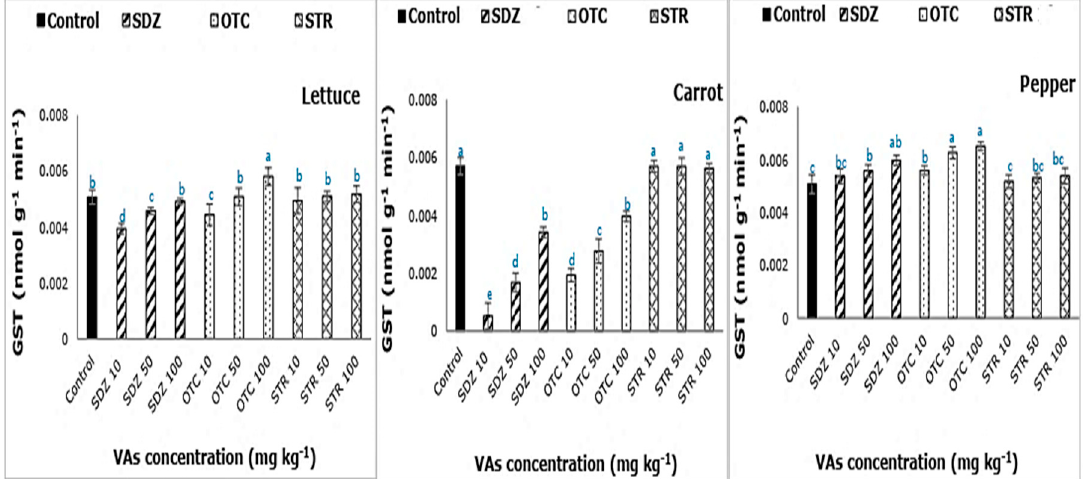
Figure 3. Glutathione-s-transferase (GST) activity of lettuce, carrot and pepper grown in soil treated with VAs. Error bars represent standard error. Concentration values followed by different letters are significantly different ( p < 0.05) according to Duncan’s multiple range test. SDZ = Sulfadimethoxine; OTC = Oxytetracycline; STR = Streptomycin.